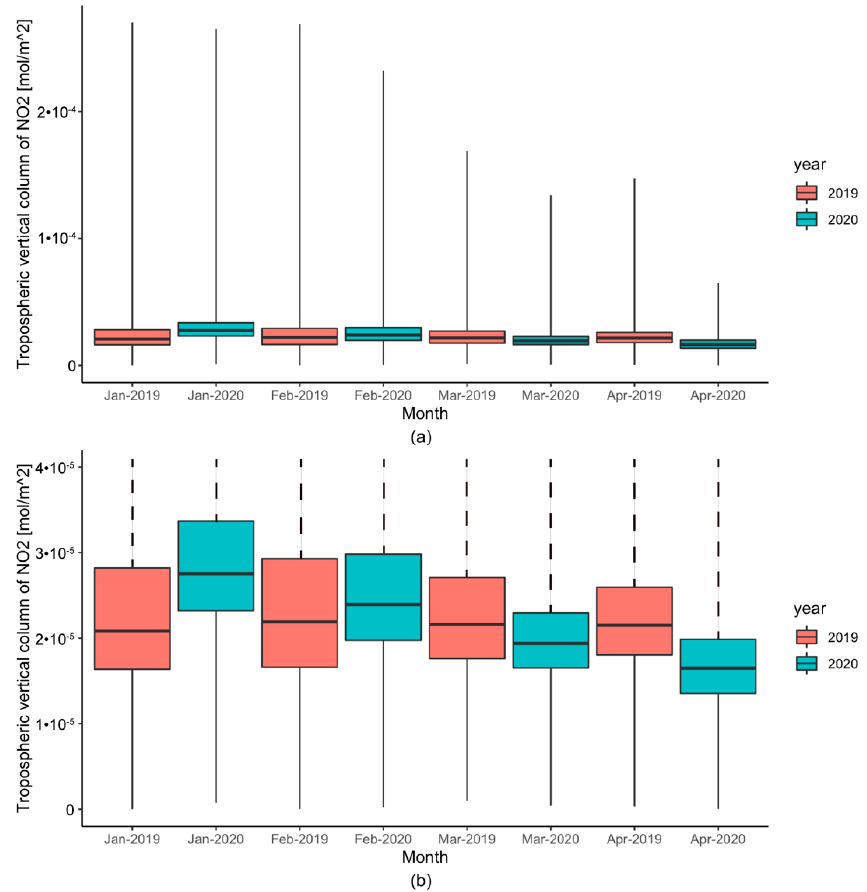
Figure 4. Whisker box plot with the monthly evolution of NO 2 in 2019 and 2020 taking into account ( a ) the whole range of values and ( b ) zoom on the median values.